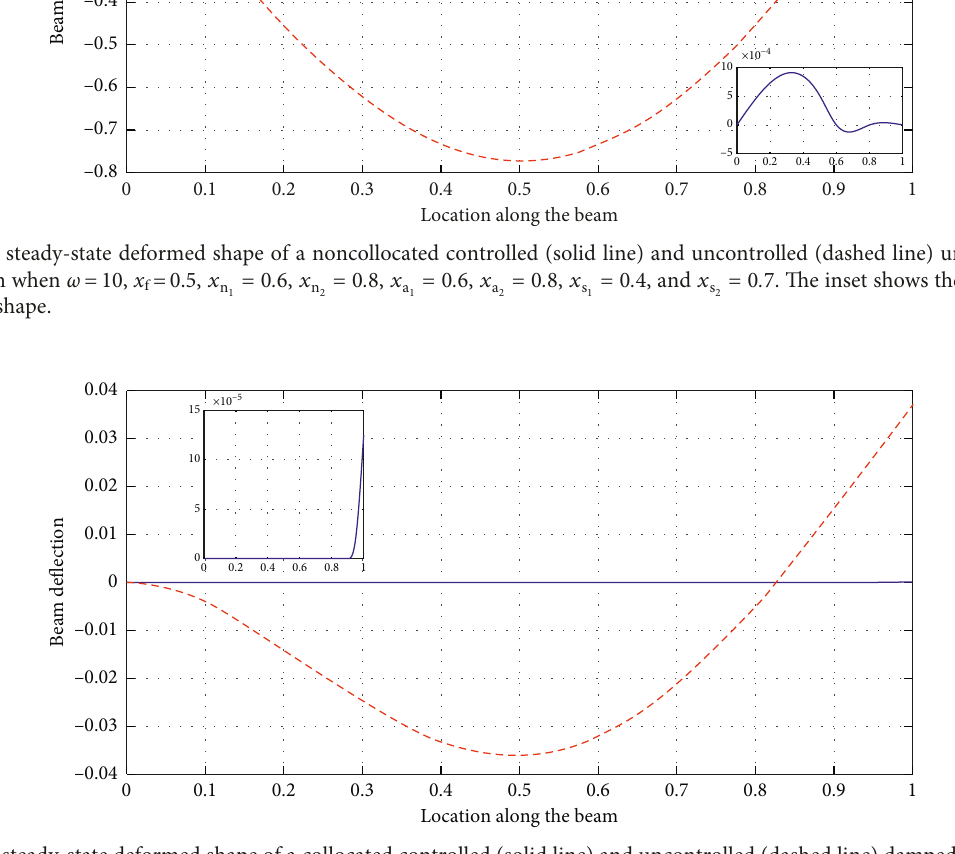
� 0 . 95, and x � 0 . 9. The inset shows the detailed plot of the controlled a 1 a 2